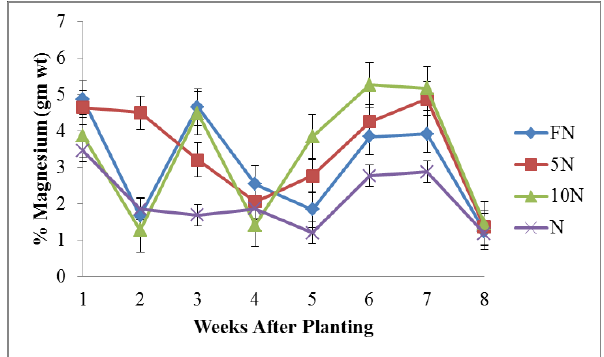
Fig. 7b. The effect of nitrogen nutritional stress on the percent- age magnesium content of Zea mays measured at different pe-